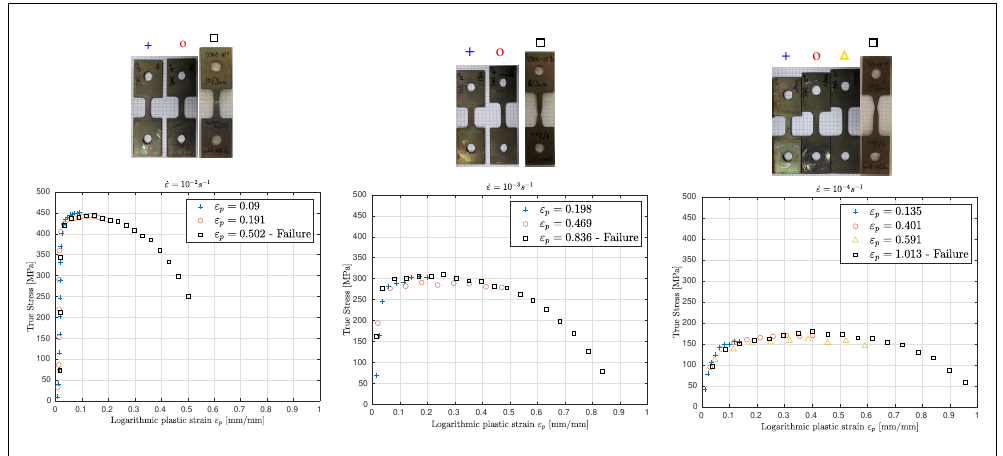
Figure 1. Plastic Stress-Strain curves performed at 730 ◦ C for several strain rate conditions and elongations.